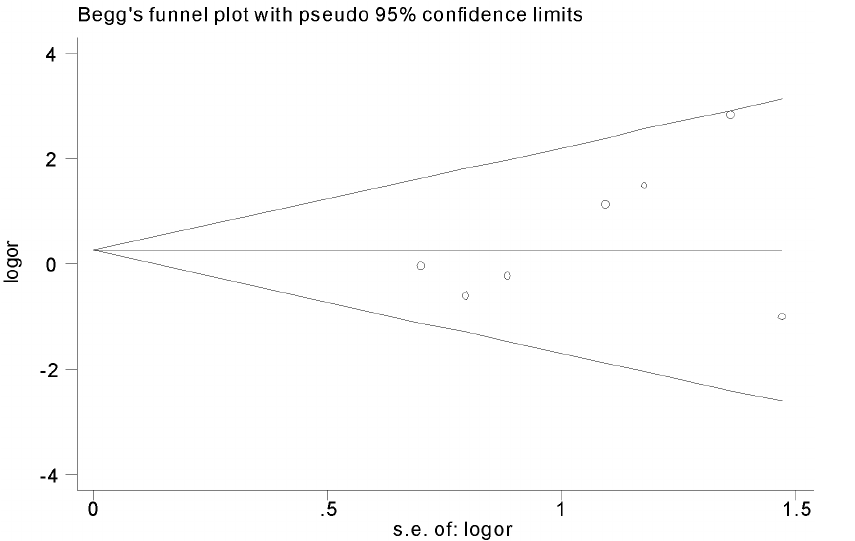
Figure 5. The funnel plot of clinical response rate when polymyxins were compared with other antibiotics in Acinectobacter baumannii infection.